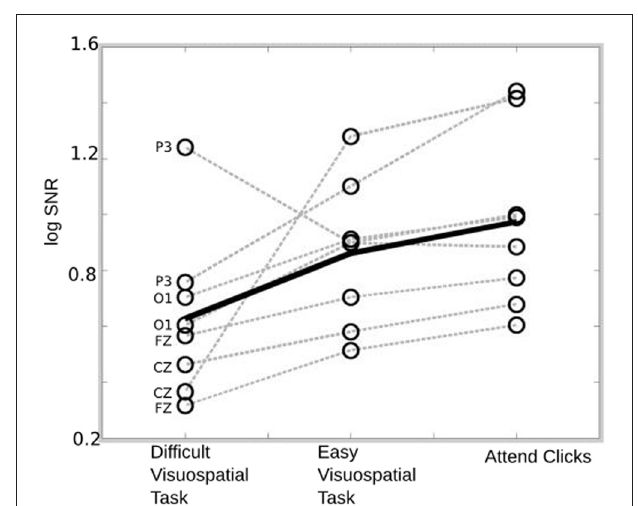
FIGURE 3 | SSAEP response for each condition. The average 40Hz response is indicated for each subject and condition (empty circles). The overall average response is indicated by the solid black line and the pattern of individual responses across conditions are indicated by the dotted gray lines. The response to the 40Hz stimulus is largest when individuals attend to the stimulus, followed by when they perform the easy visuospatial task, followed by the difficult visuospatial